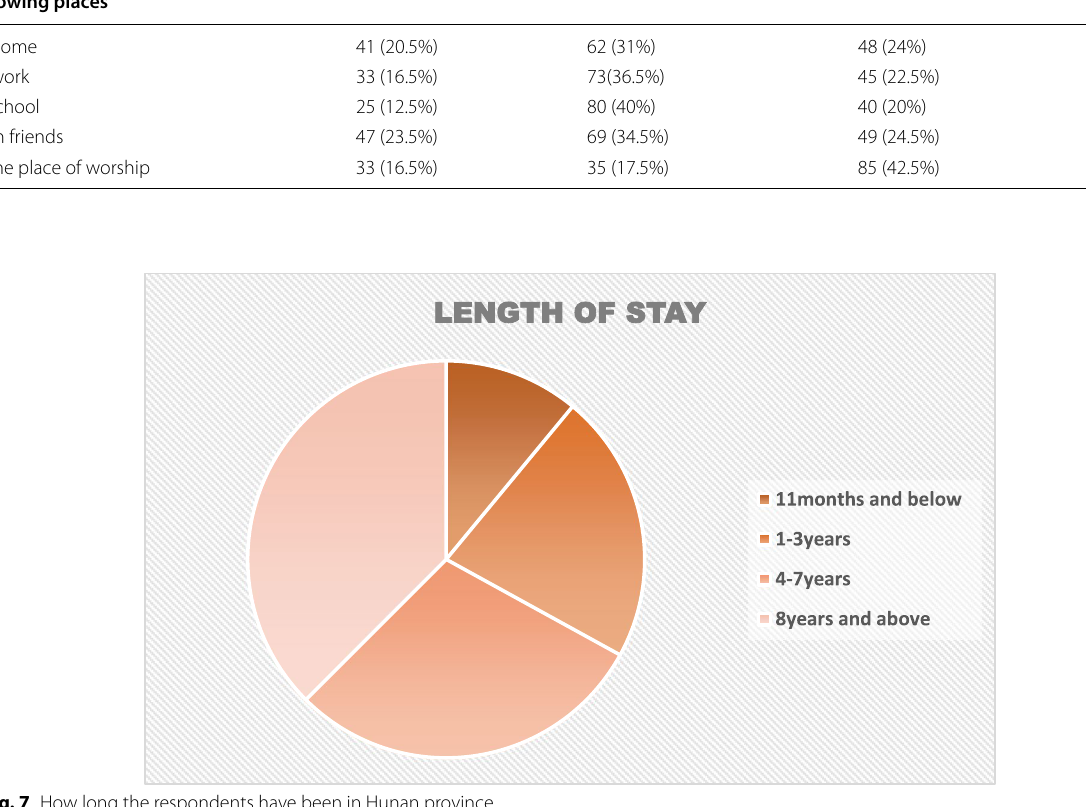
Table 10 Frequency and percentage of language use in Hunan (Staff/Audience response) Please tick the language you use in the following places